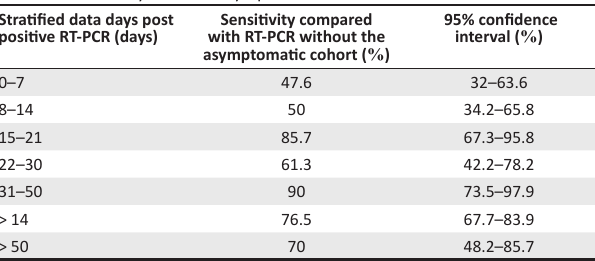
TABLE 3: Sensitivity with the asymptomatic cohort